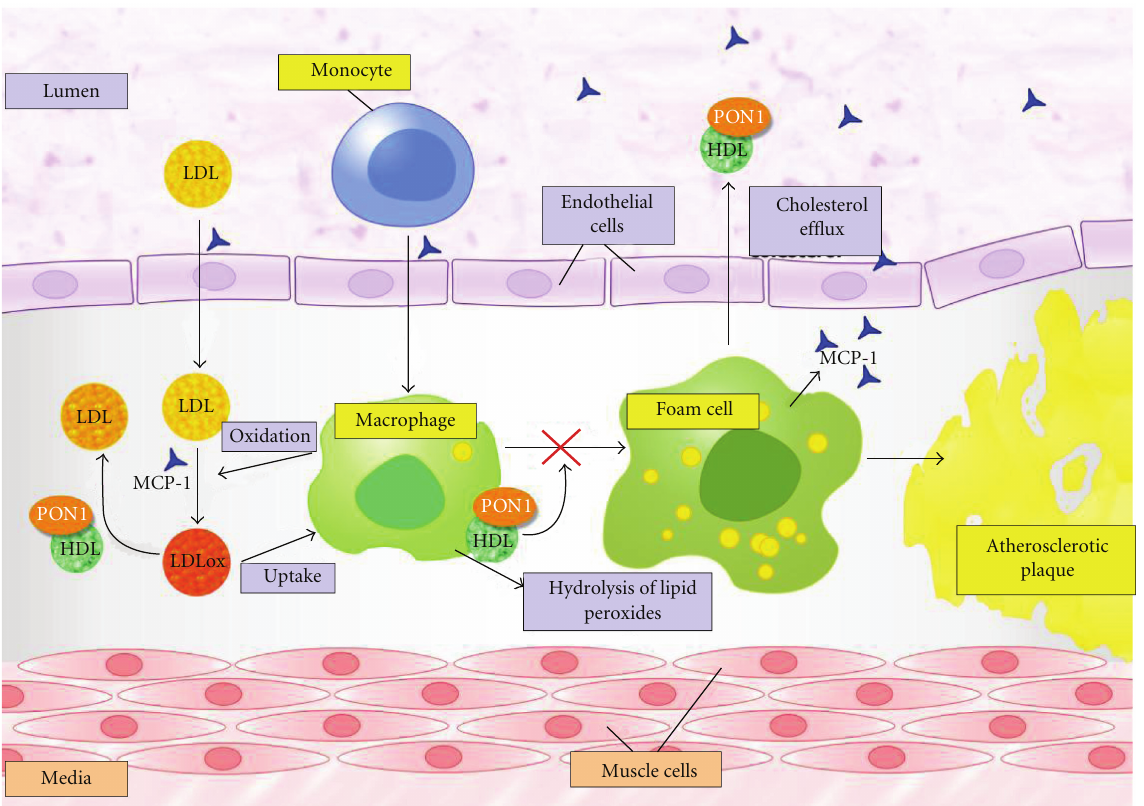
Figure 3: The protective role of PON1 in atherosclerosis. Circulating monocytes are activated in an oxidant and inflammatory environment and become macrophages. This environment also promotes the oxidation of LDL particles, which are internalized into the macrophages that become foam cells. PON1 hydrolyzes oxidized lipids in LDL, reversing this lipoprotein to its natural status and, thus, inhibiting the development of atherosclerosis. PON1, by inhibiting the production of MCP-1, is anti-inflammatory and favors cholesterol e ffl ux from